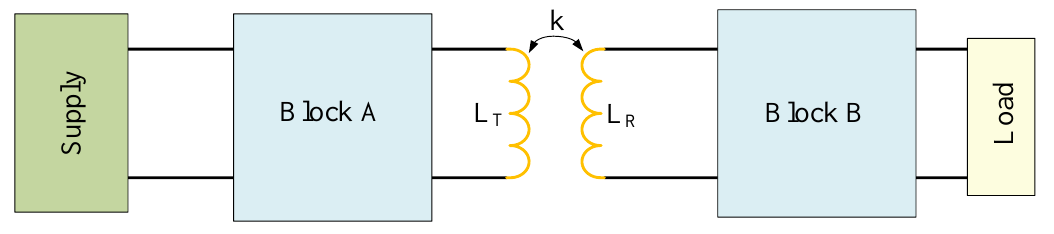
Figure 3. System for wireless power transfer.